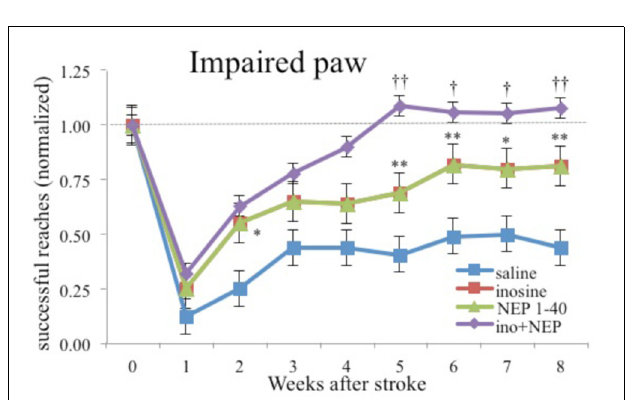
FIGURE 6 | Inosine combined with NoGo-A receptor blocker (NEP1-40) restores performance with the impaired paw to preoperative levels. Similar results were found with a combination of inosine and complex housing (after Zai et al., 2011). ∗ and ∗∗ different from saline-treated controls significant at p < 0 . 05 and p < 0 . 01 respectively. † and †† different from rats treated animals with NEP1-40 at p < 0 . 05 and p < 0 . 01